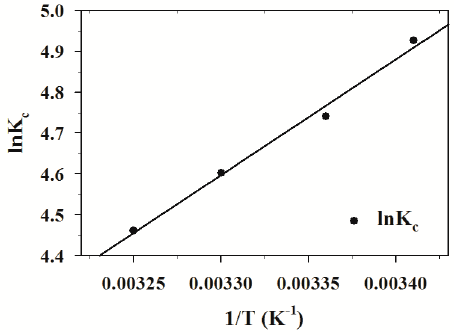
Figure 4. Plots of ln K c versus 1 / T for the adsorption of TPS onto MPS (MPS dose = 1.0 g / 50 mL, pH = 6.7, Adsorption time = 120 min, Initial conc. = 1.0 mg / mL, Temp. = 293–308 K). Table 1. Thermodynamic parameters for the adsorption of TPS onto MPS.